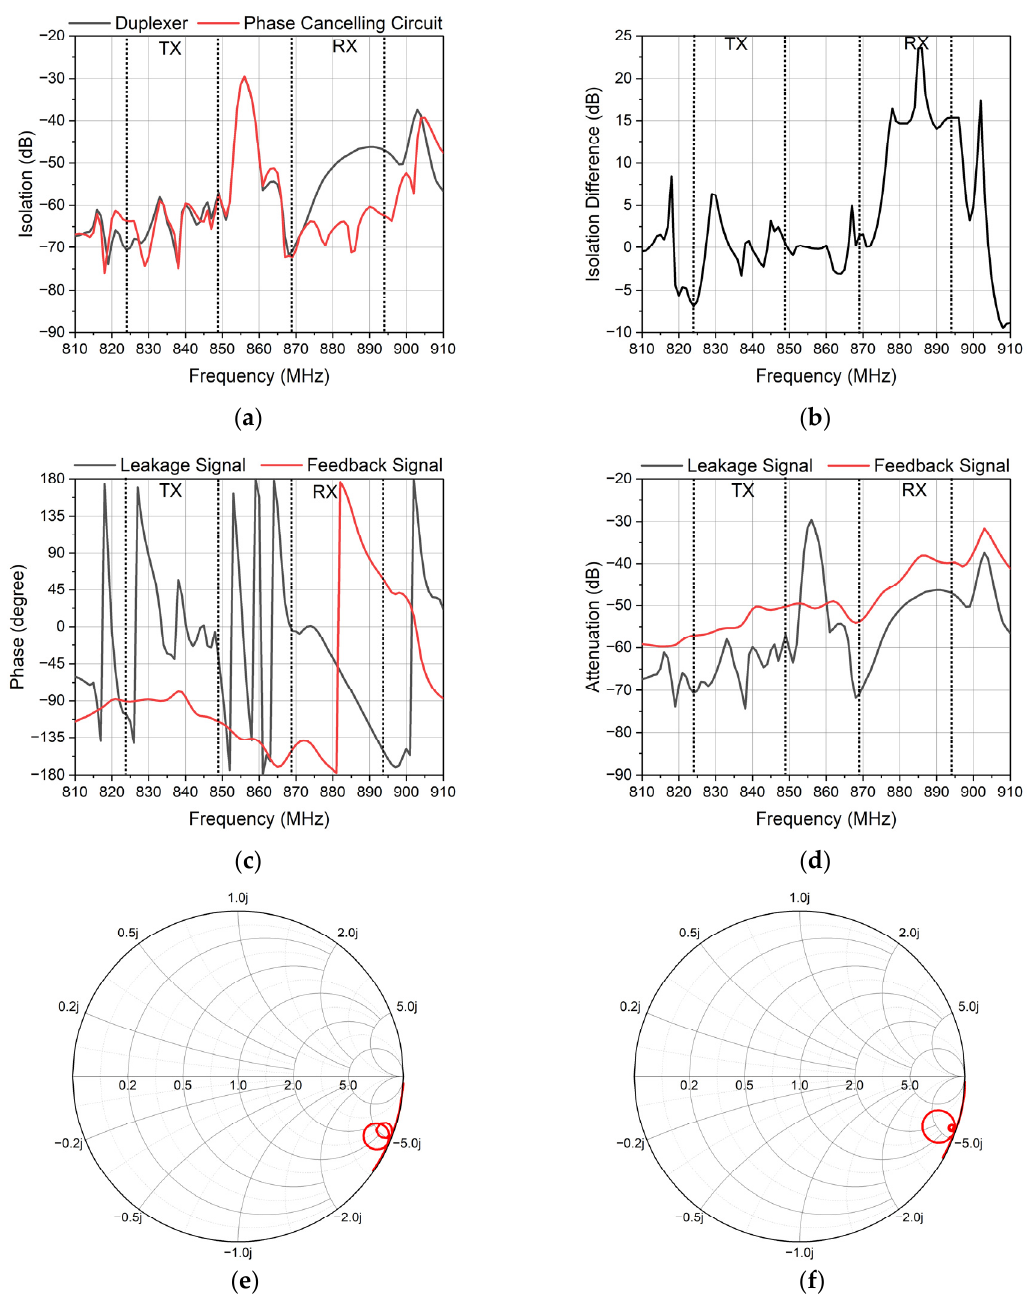
Figure 12. The simulation characteristics of the phase canceling circuit. ( a ) The isolation of the duplexer and the phase canceling circuit. ( b ) The improvement of isolation. ( c ) The phase of the feedback signal and leakage signal. ( d ) The attenuation of the feedback signal and leakage signal. ( e ) The Smith chart of the branch at the RX band. ( f ) The Smith chart of the branch at the TX band.